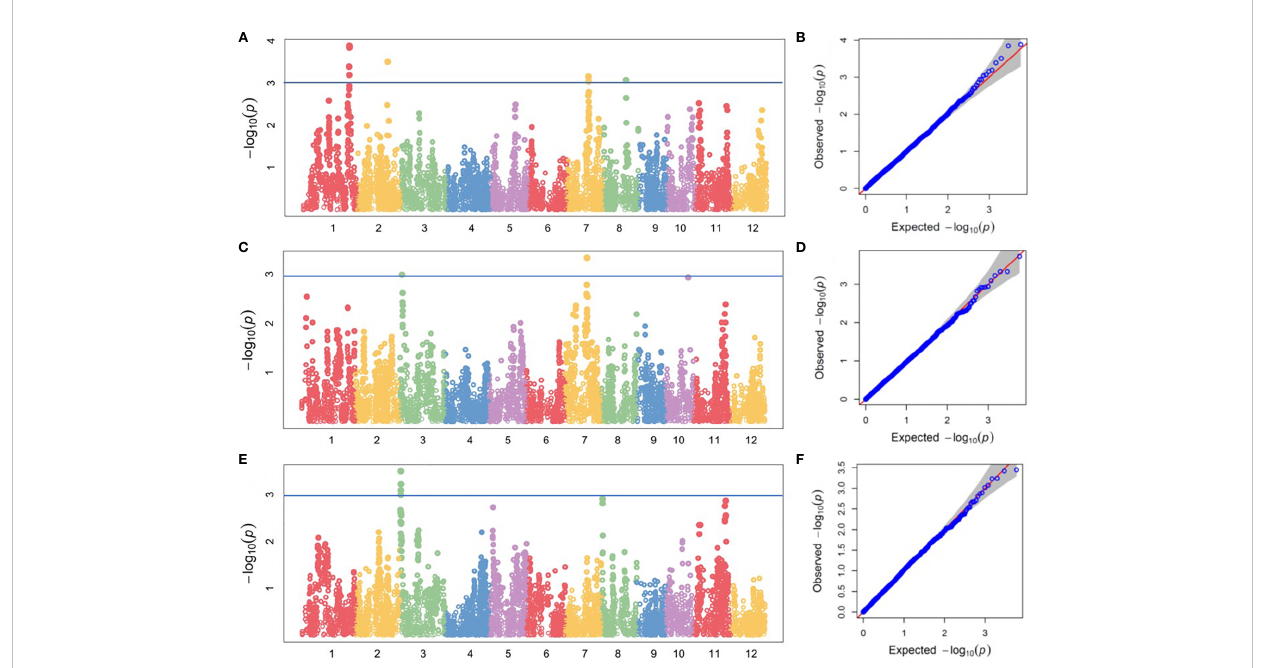
FIGURE 3 GWAS of magnesium uptake and translocation in the DC1 population. Manhattan plots of for (A) root Mg 2+ concentration, (C) shoot Mg 2+ concentration and (E) Mg 2+ content ratio of shoot to root at seedling stage; Quantile-Quantile plots for (B) root Mg 2+ concentration, (D) shoot Mg 2+ concentration and (F) shoot-to-root ratio of Mg 2+